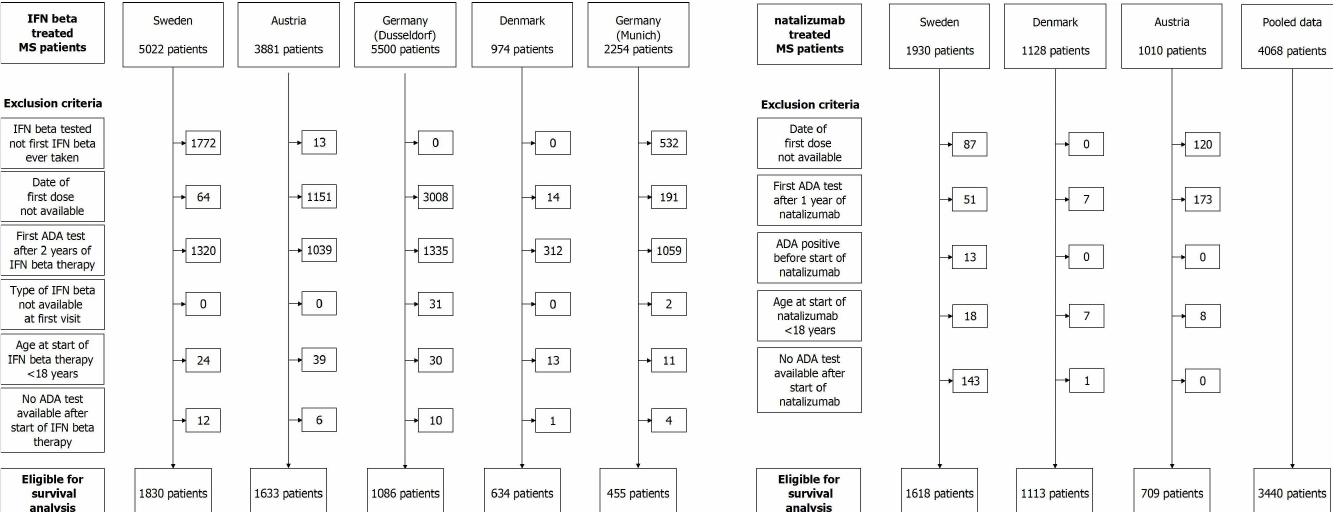
PLOS ONE | DOI:10.1371/journal.pone.0162752 November 2,